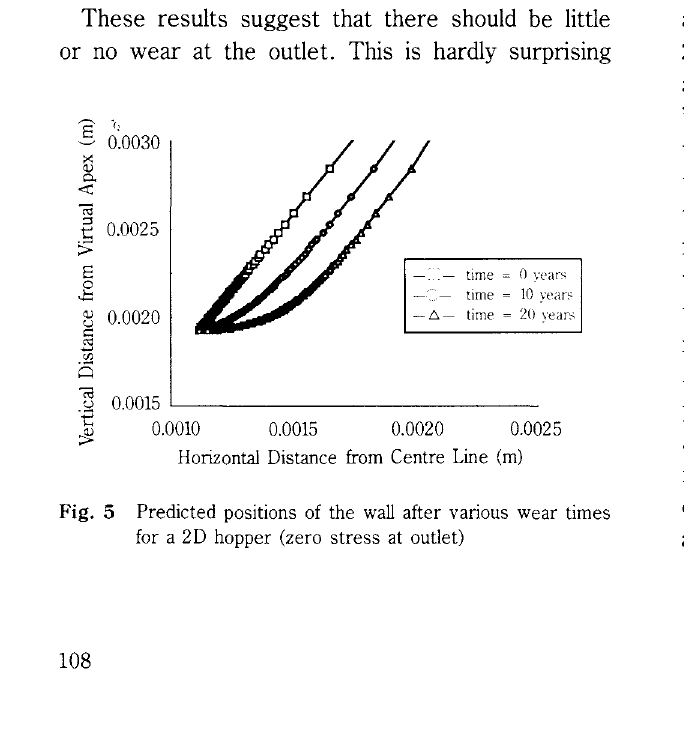
Fig. 5 Predicted positions of the wall after various wear times for a 2D hopper (zero stress at